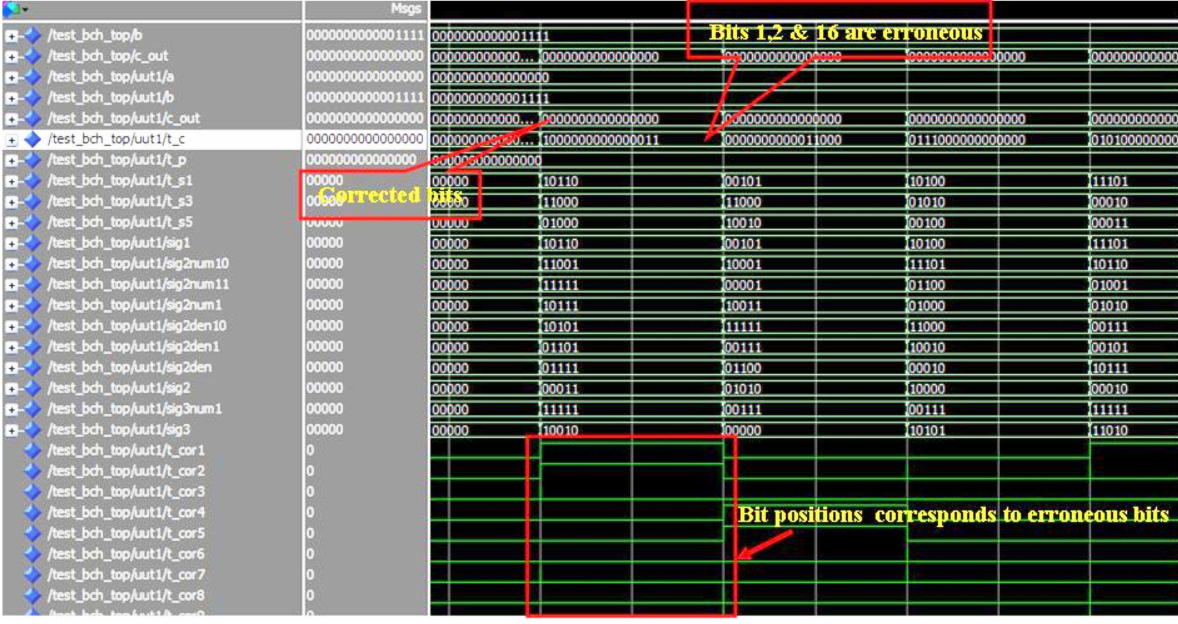
Figure 2. Simulation results of BCH code based multiple error correction.